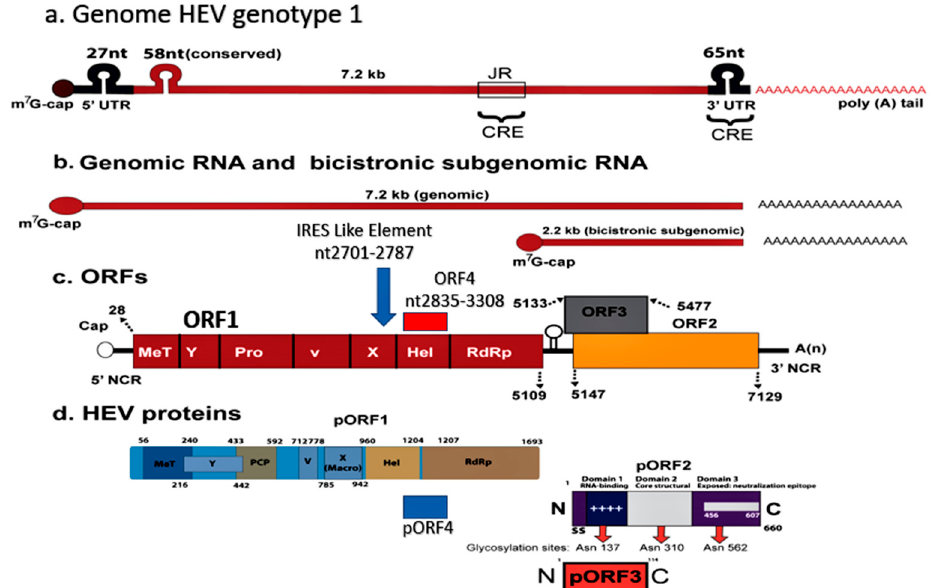
Figure 2. Hepatitis E virus Genotype 1. Genomic organization. ( a ) The hepatitis E virus genome; ( b ) Genomic RNA and bicistronic sub-genomic RNA; ( c ) Four Open reading frames (ORFs) and ( d ) Four encoded proteins (pORF1, pORF2, pORF3, and pORF4). ORF4, spanning nt2835-3308 and overlapping ORF1 in present in HEV genotype 1 alone, and its protein expression is regulated via an IRES-like RNA element (nt2701-2787). ORF4 encodes a protein (pORF4) of 124 aa, which functions to enhance viral polymerase activity and promote viral replication and is indispensable for the HEV genotype 1 life cycle.